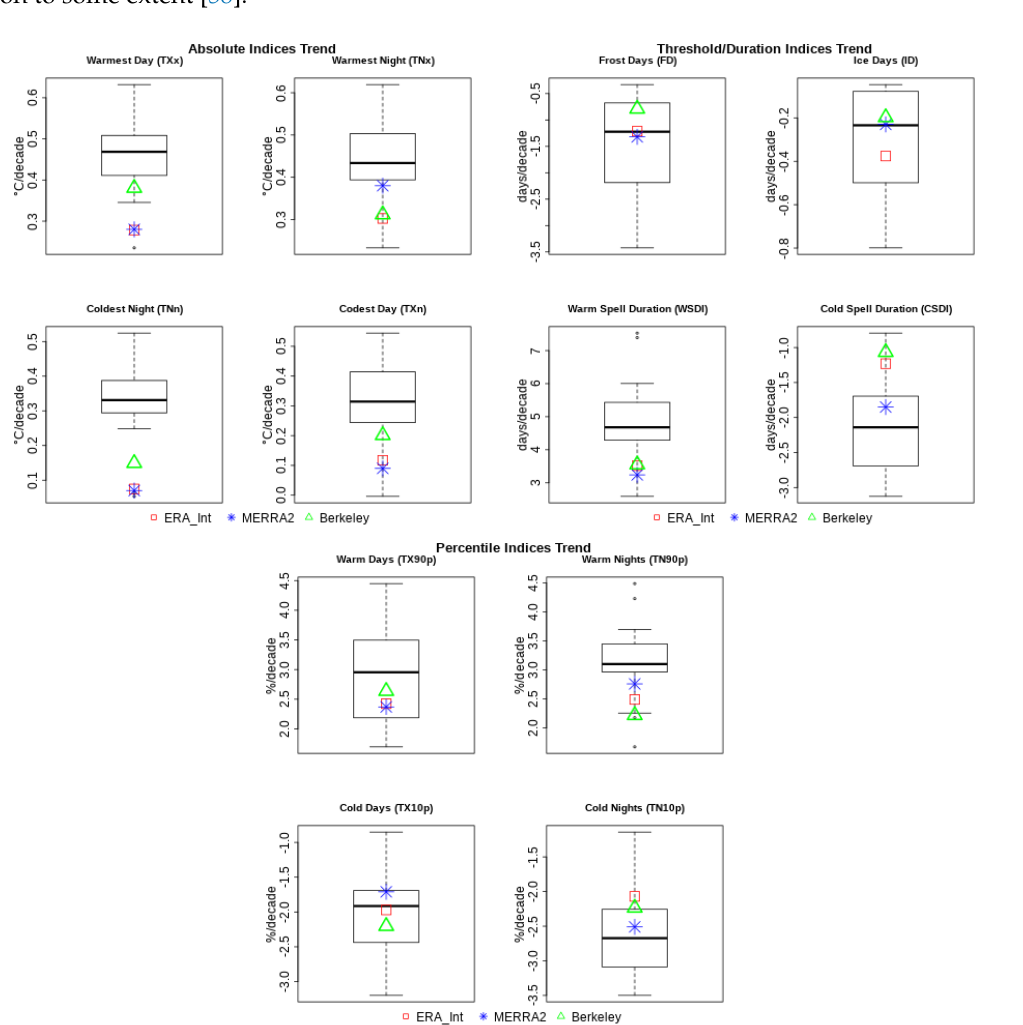
Figure 12. Same as Figure 11, but for the decadal trends of temperature